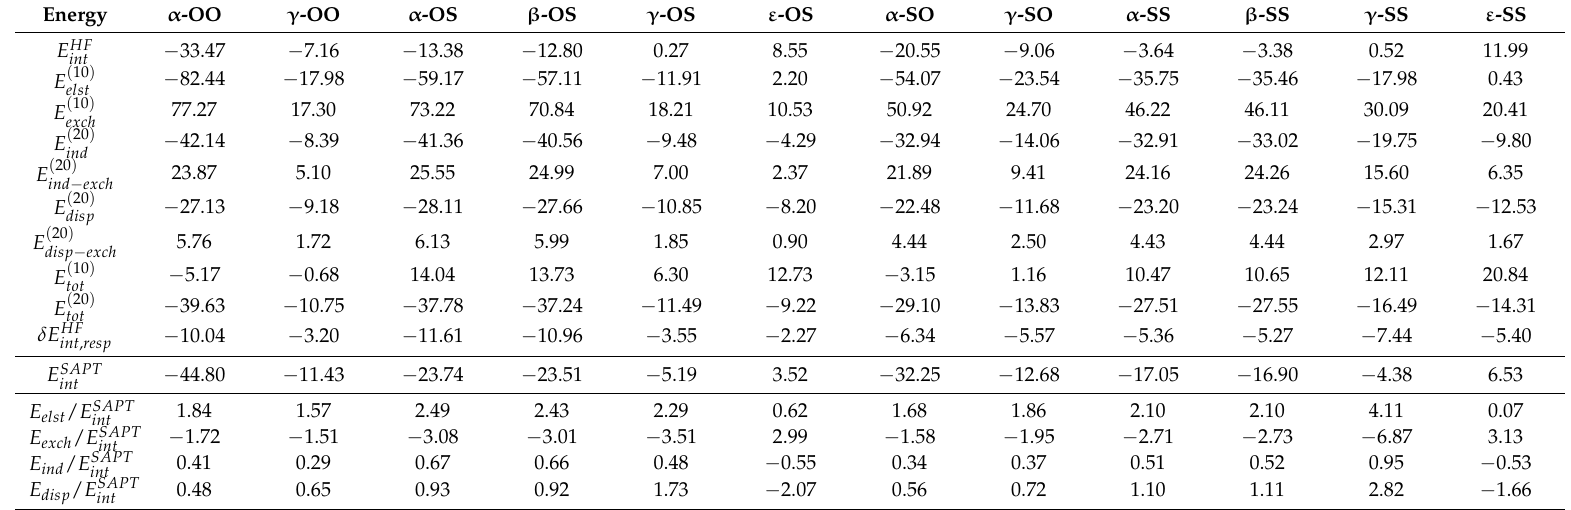
Table 4. The SAPT analysis of the intermolecular interaction energy in kJ · mol − 1